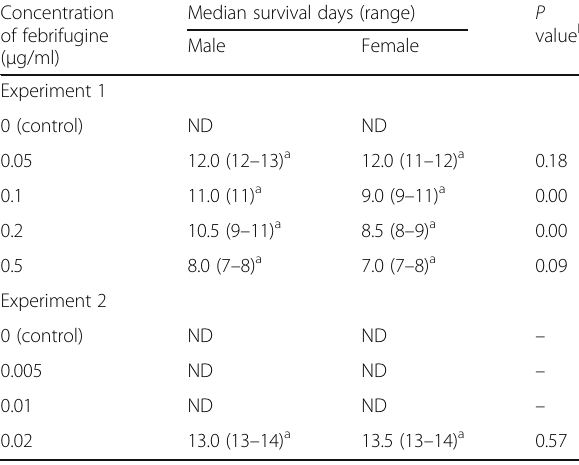
Table 2 Effect of febrifugine on the survival time of six paired Schistosoma mansoni adult worms within 14 days Concentration of